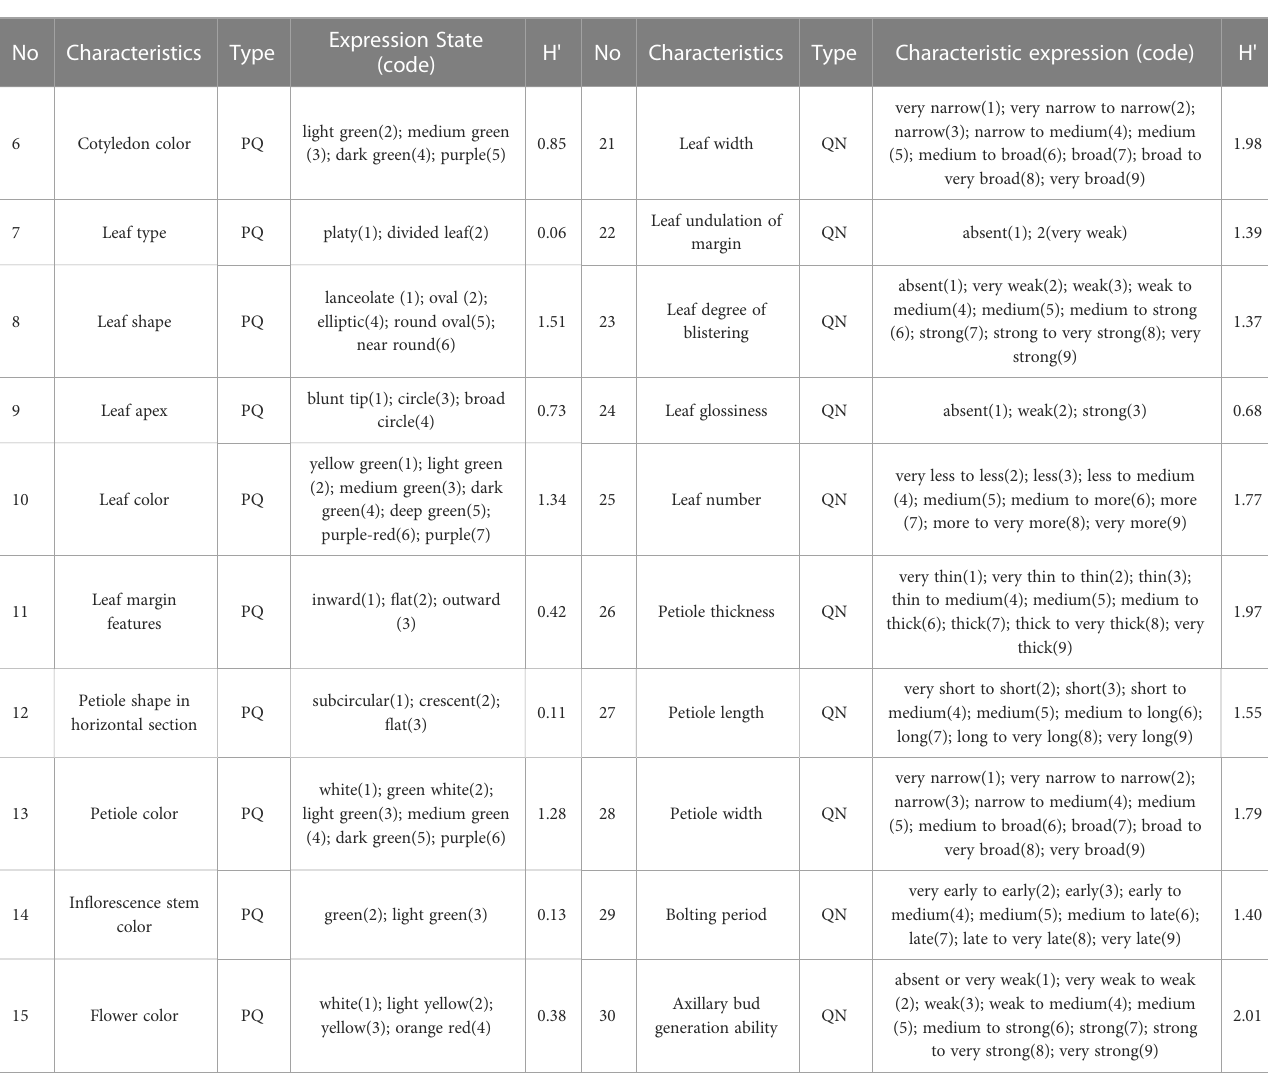
accordance with non-heading Chinese cabbage DUS test guidelines investigated (Table 1): four qualitative characteristics, 11 pseudo- qualitative characteristics, and 15 quantitative characteristics. The Shannon – Wiener diversity index of morphological